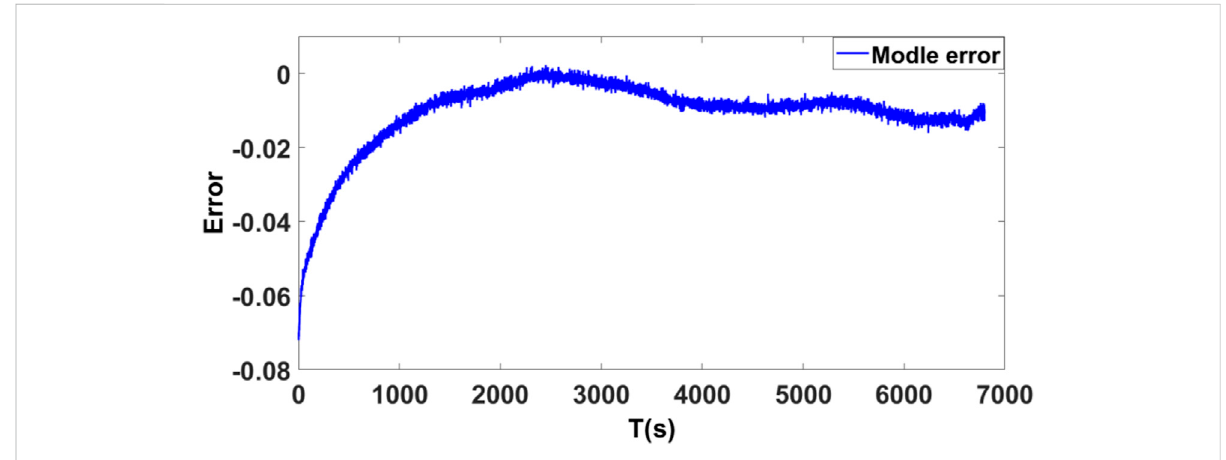
FIGURE 5 Model voltage and true voltage udder constant current test.